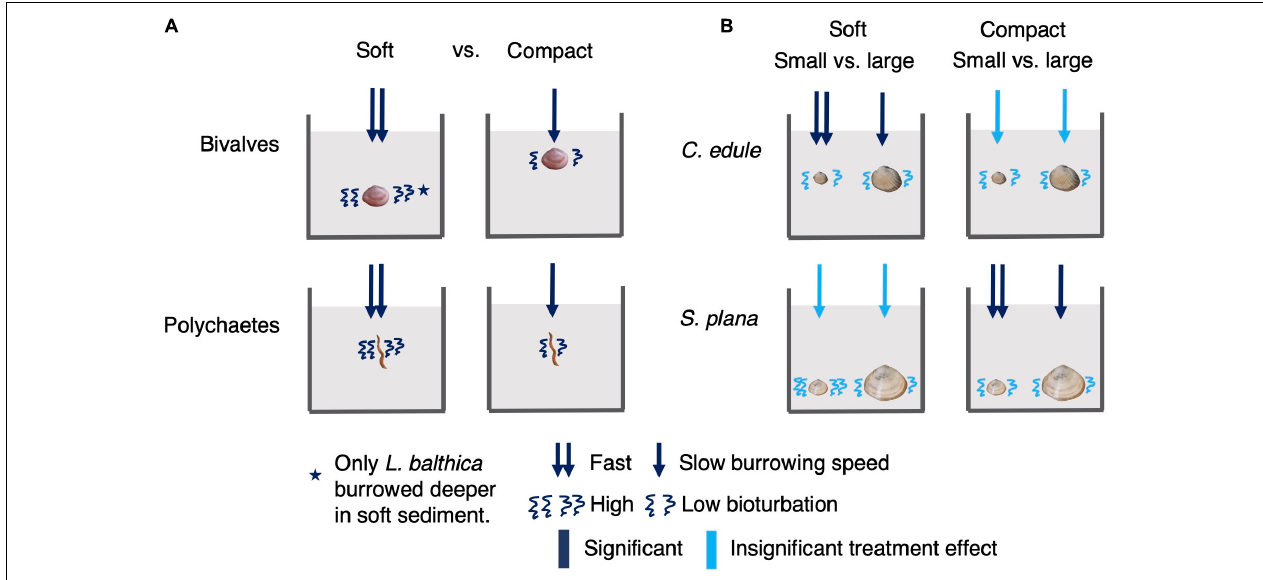
FIGURE 10 | Summary of sediment bulk density treatment main effects on burrowing speed, depth, and bioturbation amount. Because there were no significant interactions between sediment bulk density and grain size, we show a single figure to summarize bulk density effects under the different sediment grain sizes. We did not present respiration effects as there were no significant sediment bulk density effects on respiration. The left panel (A) shows bulk density treatment main effects on bivalves and polychaetes. The effect pertains to all bivalves or polychaetes unless indicated with a star. The right panel (B) shows comparisons between C. edule and S. plana size class responses under soft and compact